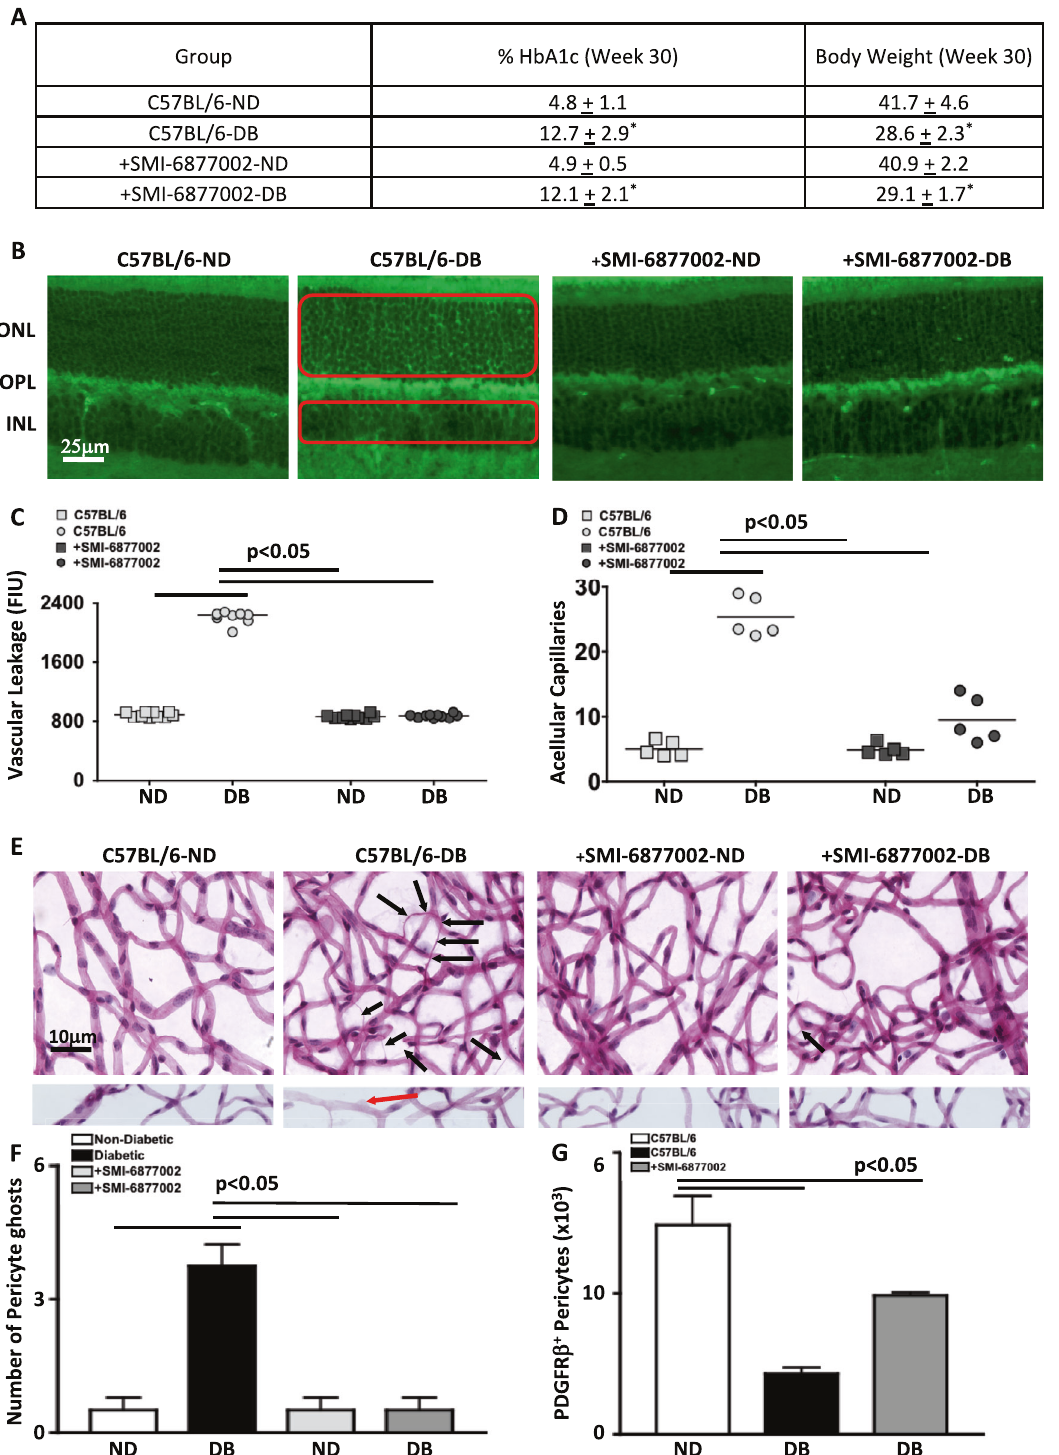
arrow in the lower panel of Fig. 2E). There was a signi fi cantly higher number of pericyte ghosts in the capillaries of untreated diabetic mice than all non-diabetic mice and the SMI-6877002 treated diabetic mice (Fig. 2F). Conversely, the number of viable PDGFR β + pericytes were quanti fi ed in the retinas ( n = 3